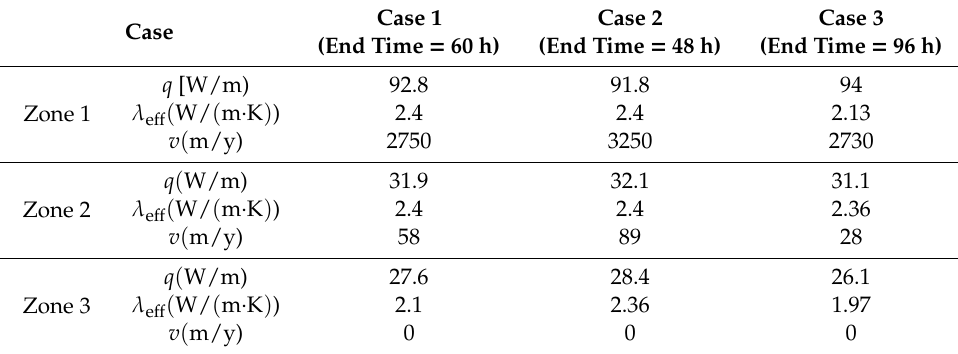
Table 2. Results of the thermal parameter according to the end time.